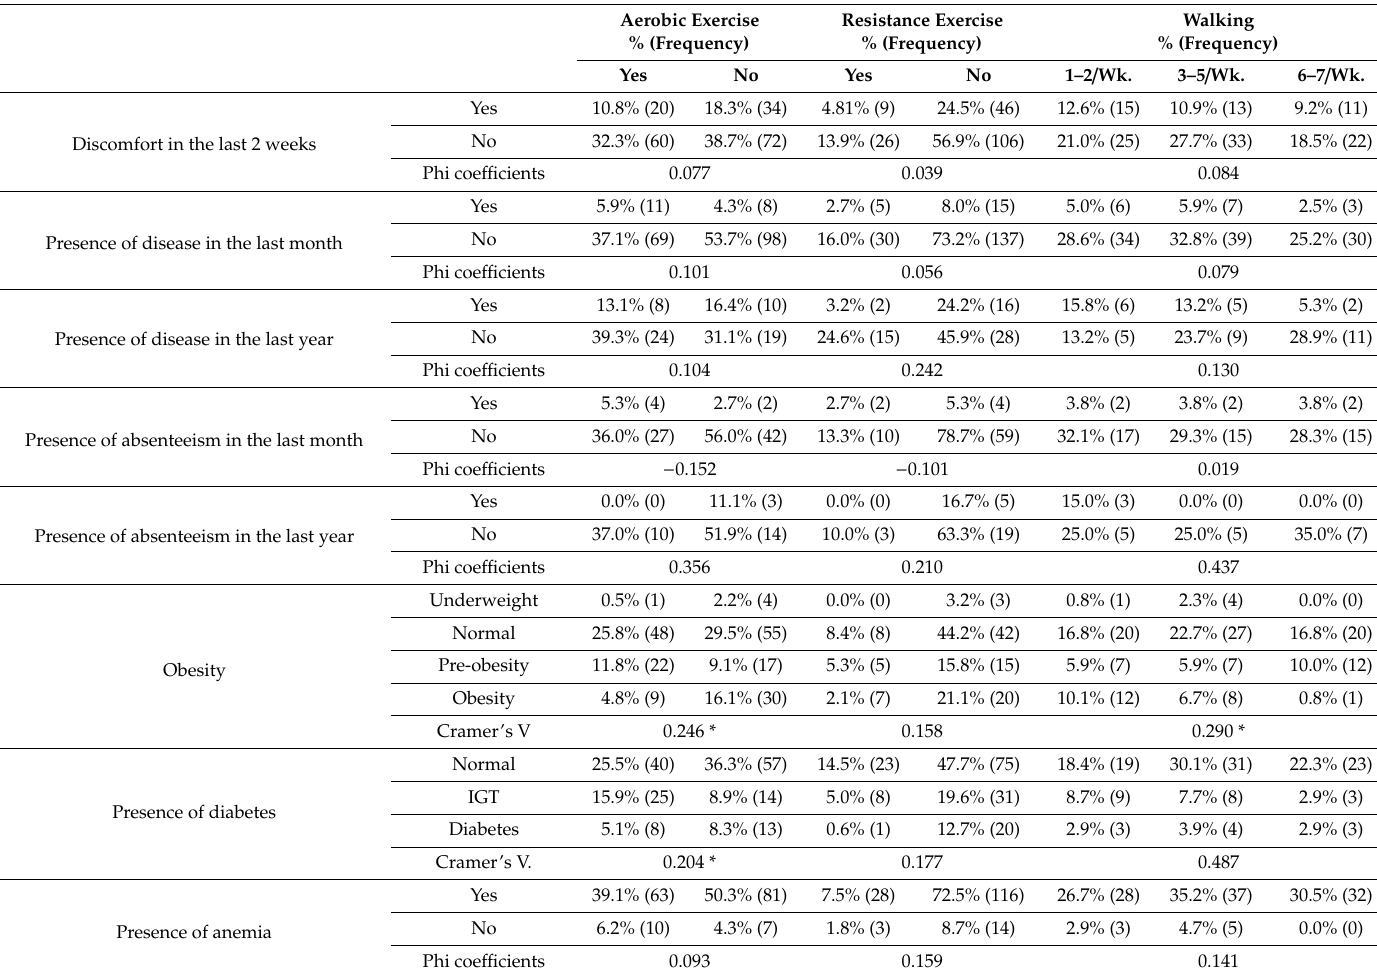
Table 2. Correlation between exercise modality and activity restriction-related variants in breast cancer